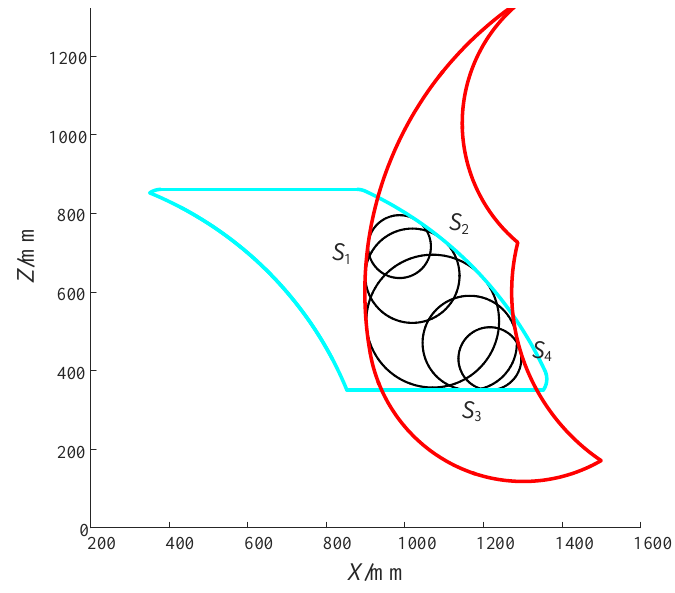
Figure 11. Circle training trajectory.